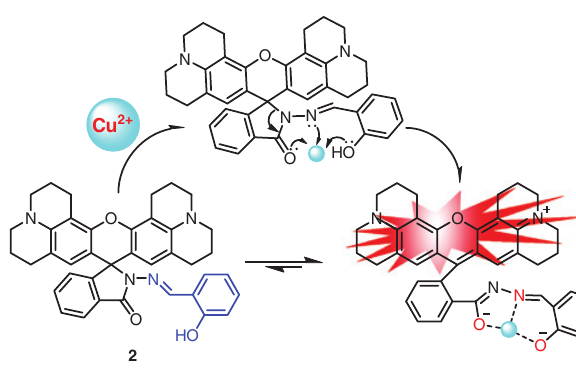
Figure 5: Recognition mechanism of probe 2 with Cu 2 +